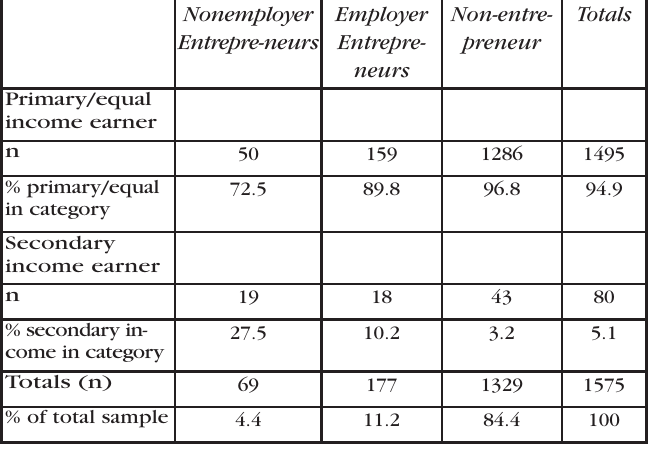
Table 5. Composition of Sample by Income Status